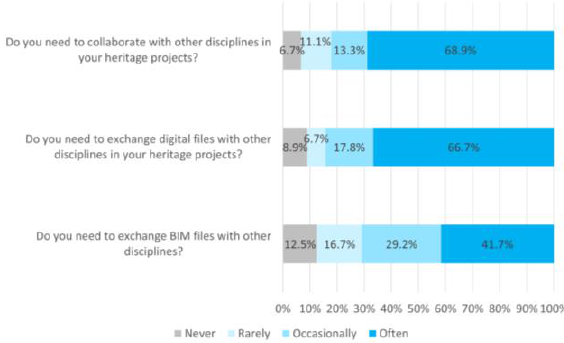
Figure 11: Responses of the heritage sector participants concerning their needs for collaboration with other disciplines, exchange of digital data and exchange of BIM data.